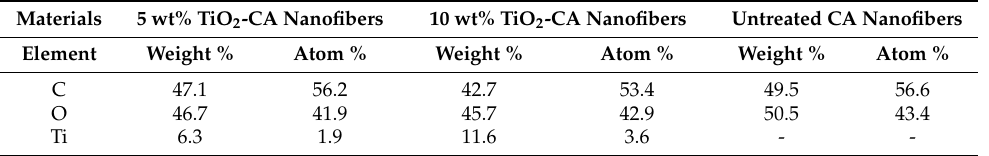
Table 1. Quantitative analysis of untreated CA and TiO 2 -CA nanofibers.